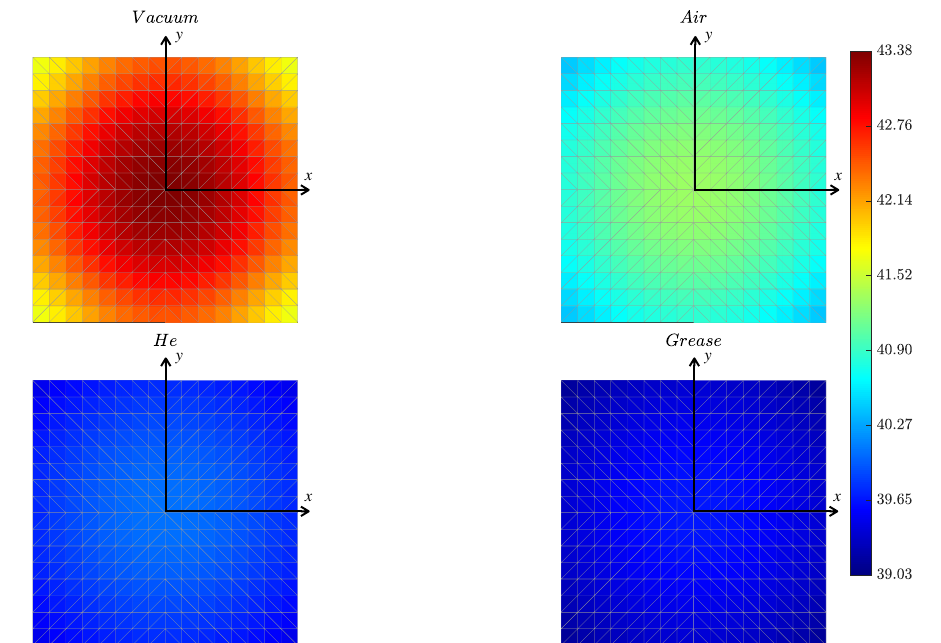
Figure A7. Complete temperature distribution θ [ ◦ C] comparison on the base of the microprocessor for each TIM analyzed.